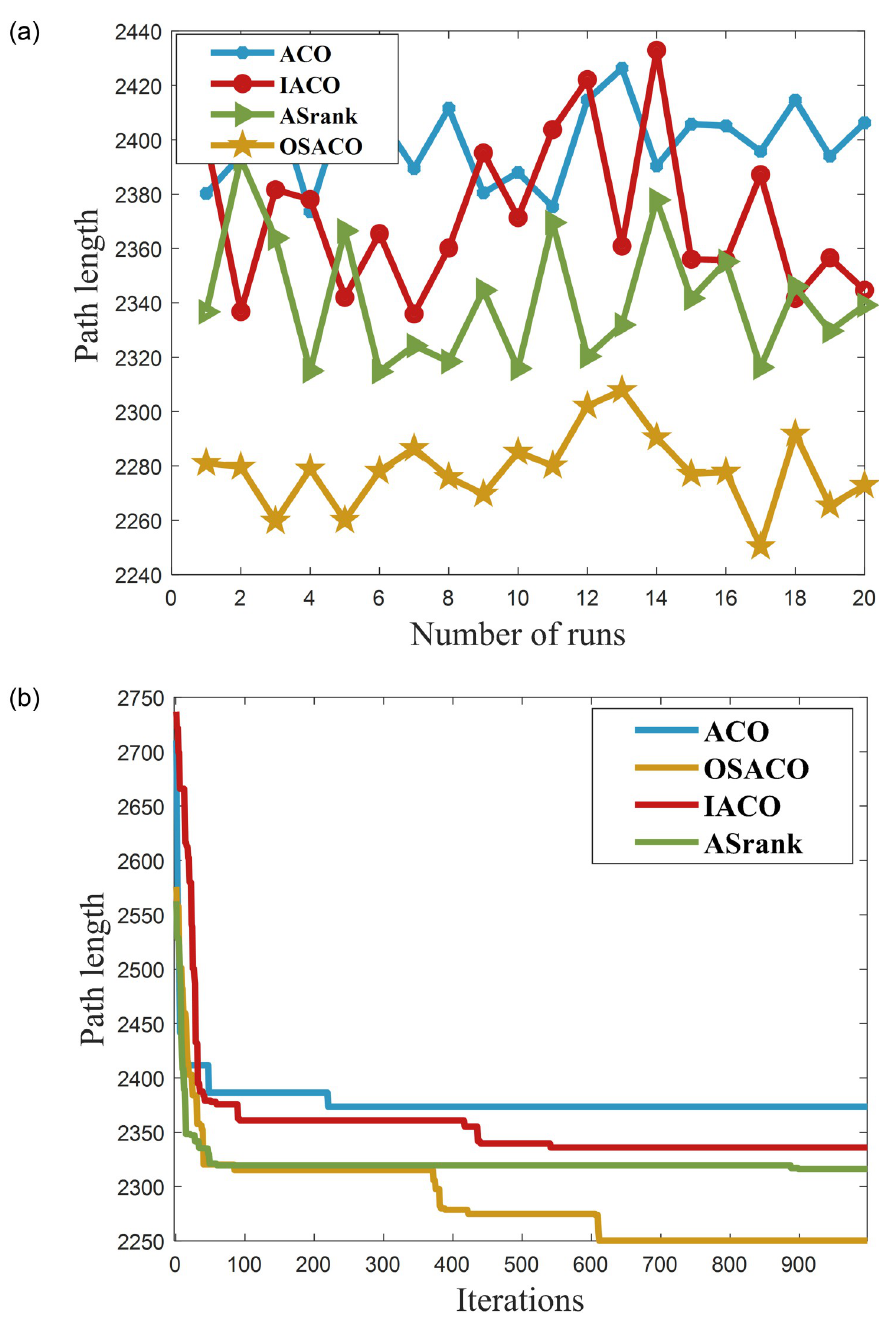
Fig 4. Number of independent runs and convergence curves of the four algorithms at 150 fruit numbers. (a) Four algorithms run independently for 20 times result graph. (b) Convergence curves under the optimal path conditions.